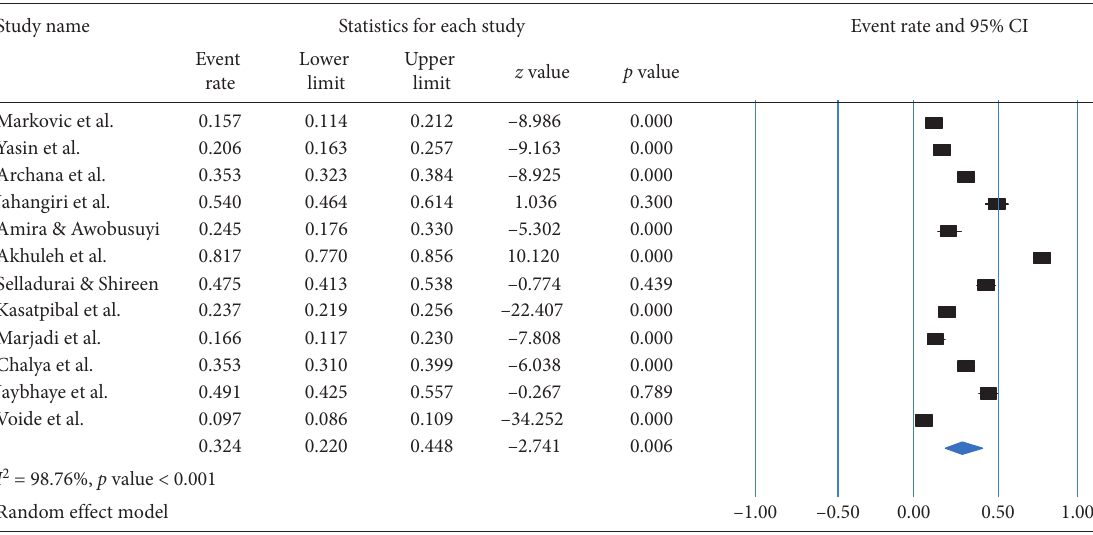
Figure 5: Forest plot shows the pooled prevalence of occupational exposure to needle stick injury in the previous one